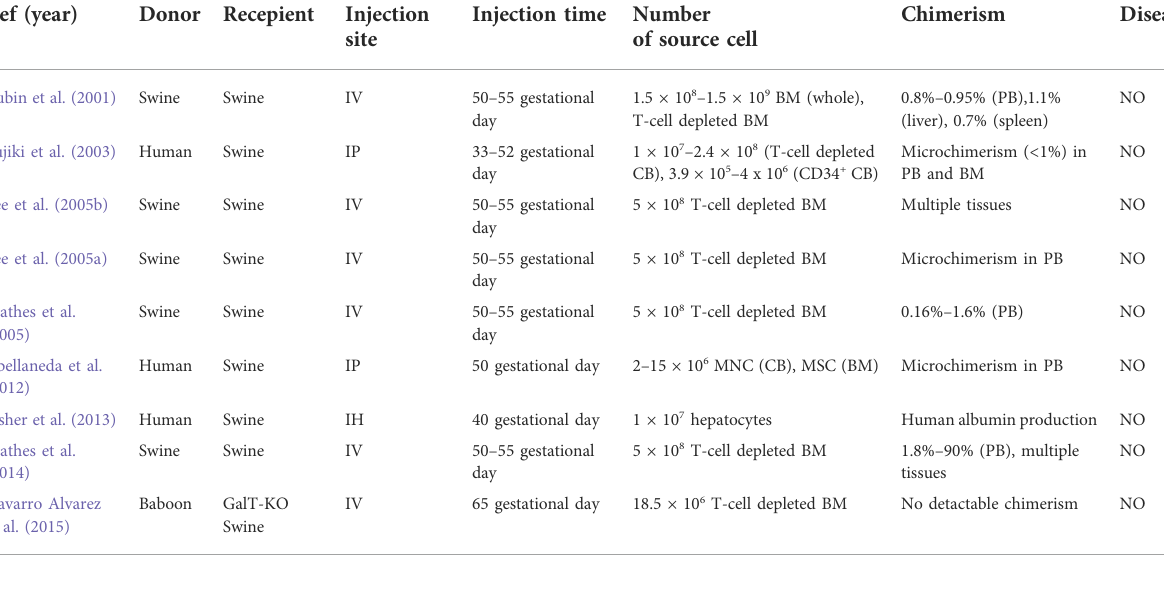
TABLE 4 IUT in swine model.